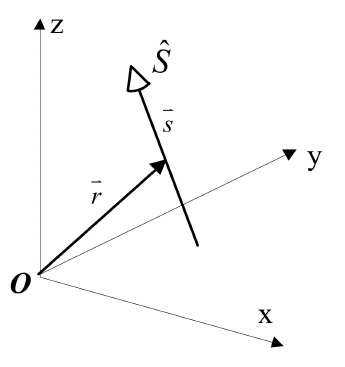
Figure 4. Definition of joint